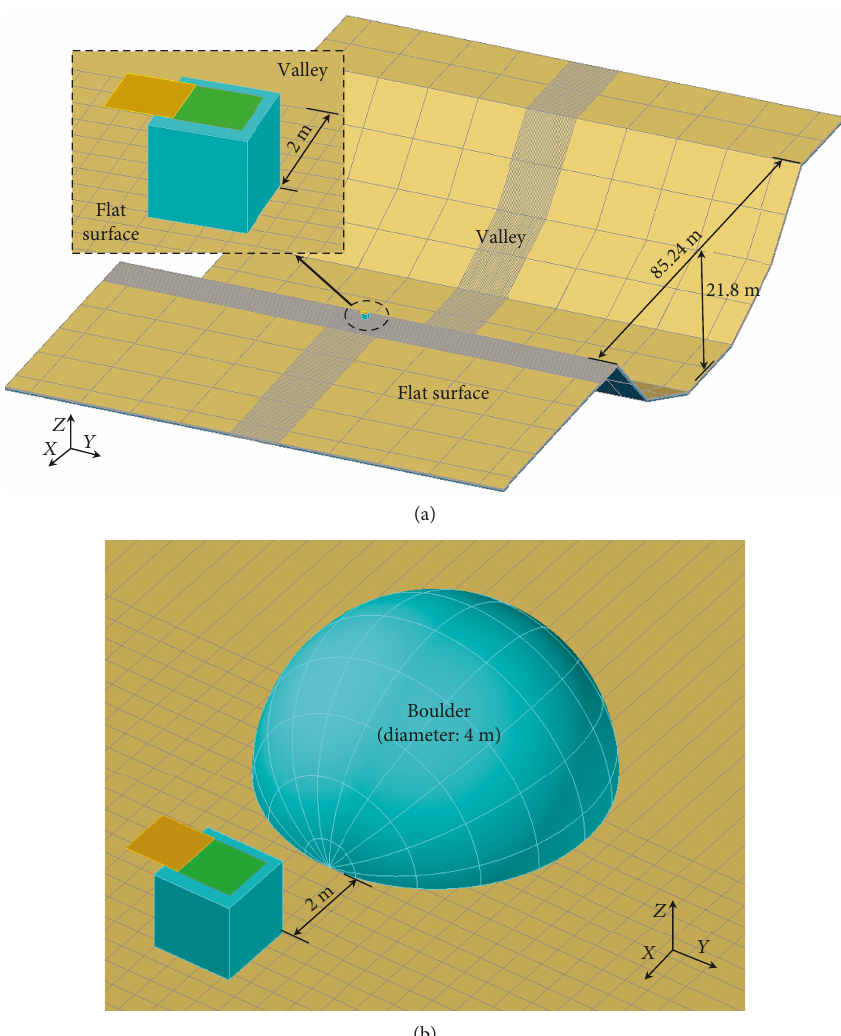
Figure 7: TMMs of the lunar lander exposed to various surface features of the regolith ((a) with valley and (b) with